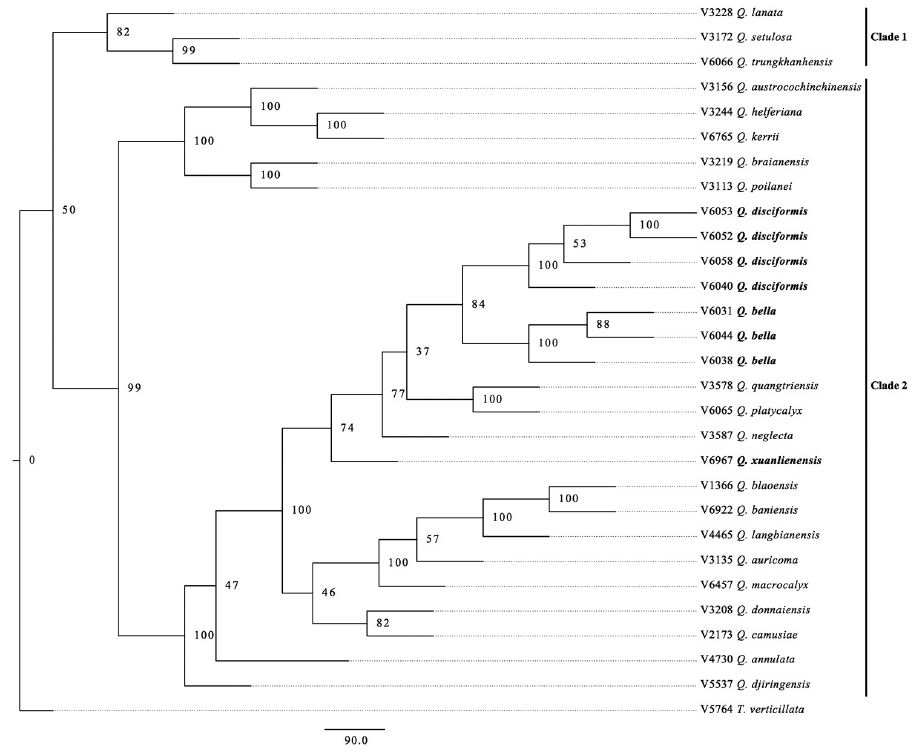
Figure 2. NJ tree of 28 samples of Quercus and one Trigonobalanus (outgroup) based on presence/ab- sence data of 19,916 MIG-seq loci. Branches are labelled with bootstrap support (% of 1000